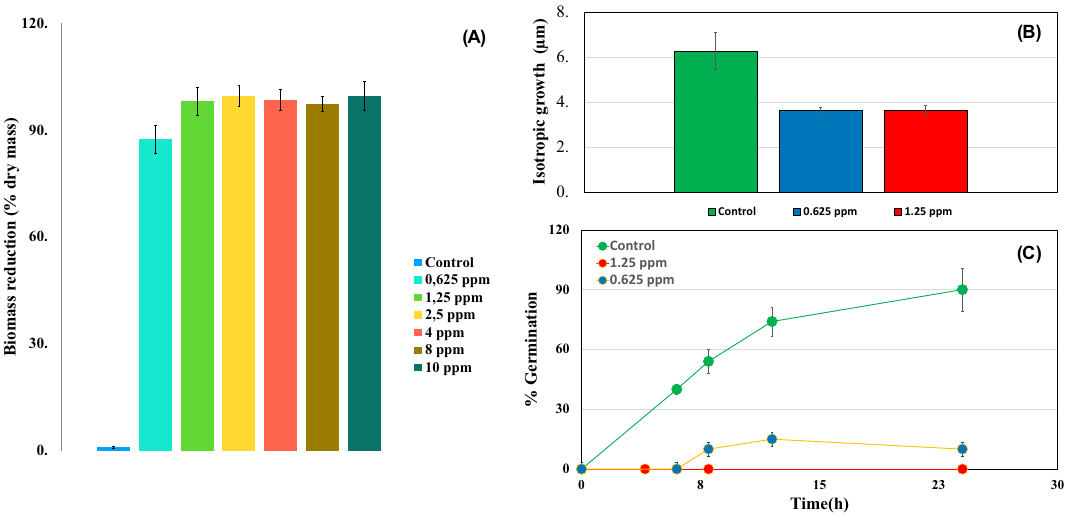
Figure 1. ( A ) Reduction of mycelia growth. 0,2 g of A. niger GM31 mycelia was growth at different concentrations of SUNCs in MEB at 28 °C for 7 days.Untreated mycelia was used as a control. The mycelial growth inhibition, measured as the percentage of dried mycelia biomass, was determined according to Eq. (1) (materials and methods). ( B ) The effect of Arg-SUNCs on the conidia germination. Conidia suspension (9.8 × 10 6 CFU mL −1 ) were incubated at different concentrations of SUNCs at 28 °C at different time. (C) Dimension of the spores during this first phase at different concentrations of SUNCs within 4 h at 28 °C. The analysis of variance (ANOVA) was carried out to every variable studied ( P <